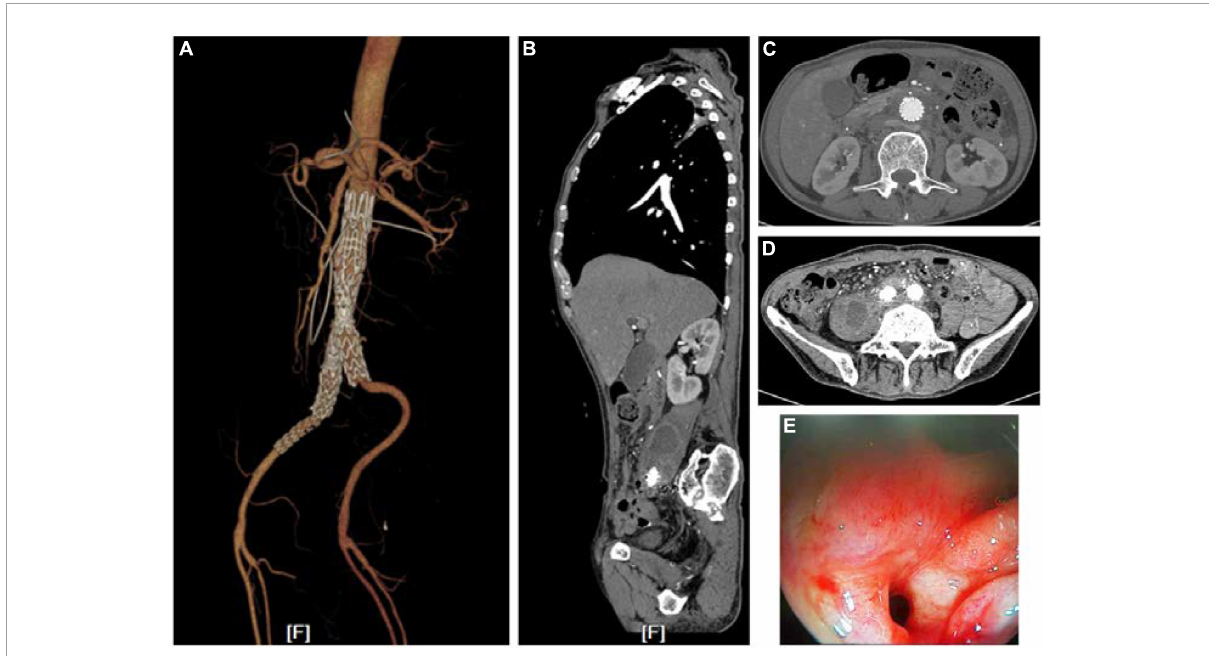
FIGURE1 Images of CTA and endoscopy before treatments. (A) Endovascular repair and drainage had been performed when the patient was hospitalized. (B–D) A low-density shadow hinting at an abscess in the right psoas major muscle and around the stenting. (E) Fistulae in the horizontal part of duodenum found via